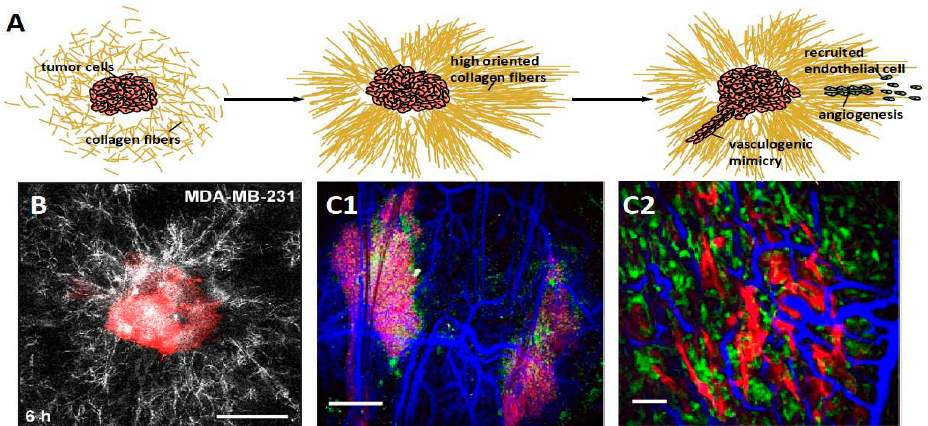
Figure 3. Tumor cells organize the disordered collagen fibers into orientation, further providing a scaffold to recruit endothelial cells (green cell in illustration) for angiogenesis or inducing vasculogenic mimicry constituted by tumor cells (red cell in illustration) without endothelial cells presenting. ( A ) The cartoon diagram displays the process of angiogenesis. ( B ) A confocal image of a representative tissue comprised of breast cancer cell MDA-MB-231. The collagen fibers around the tissue are aligned, obviously. Reprinted/adapted with permission from Ref. [76]. ( C1 , C2 ) The SHG images show the vasculature (blue) formed neighbor tumor within the micro-environment of high dense collagen matrix. Reprinted/adapted with permission from Ref.